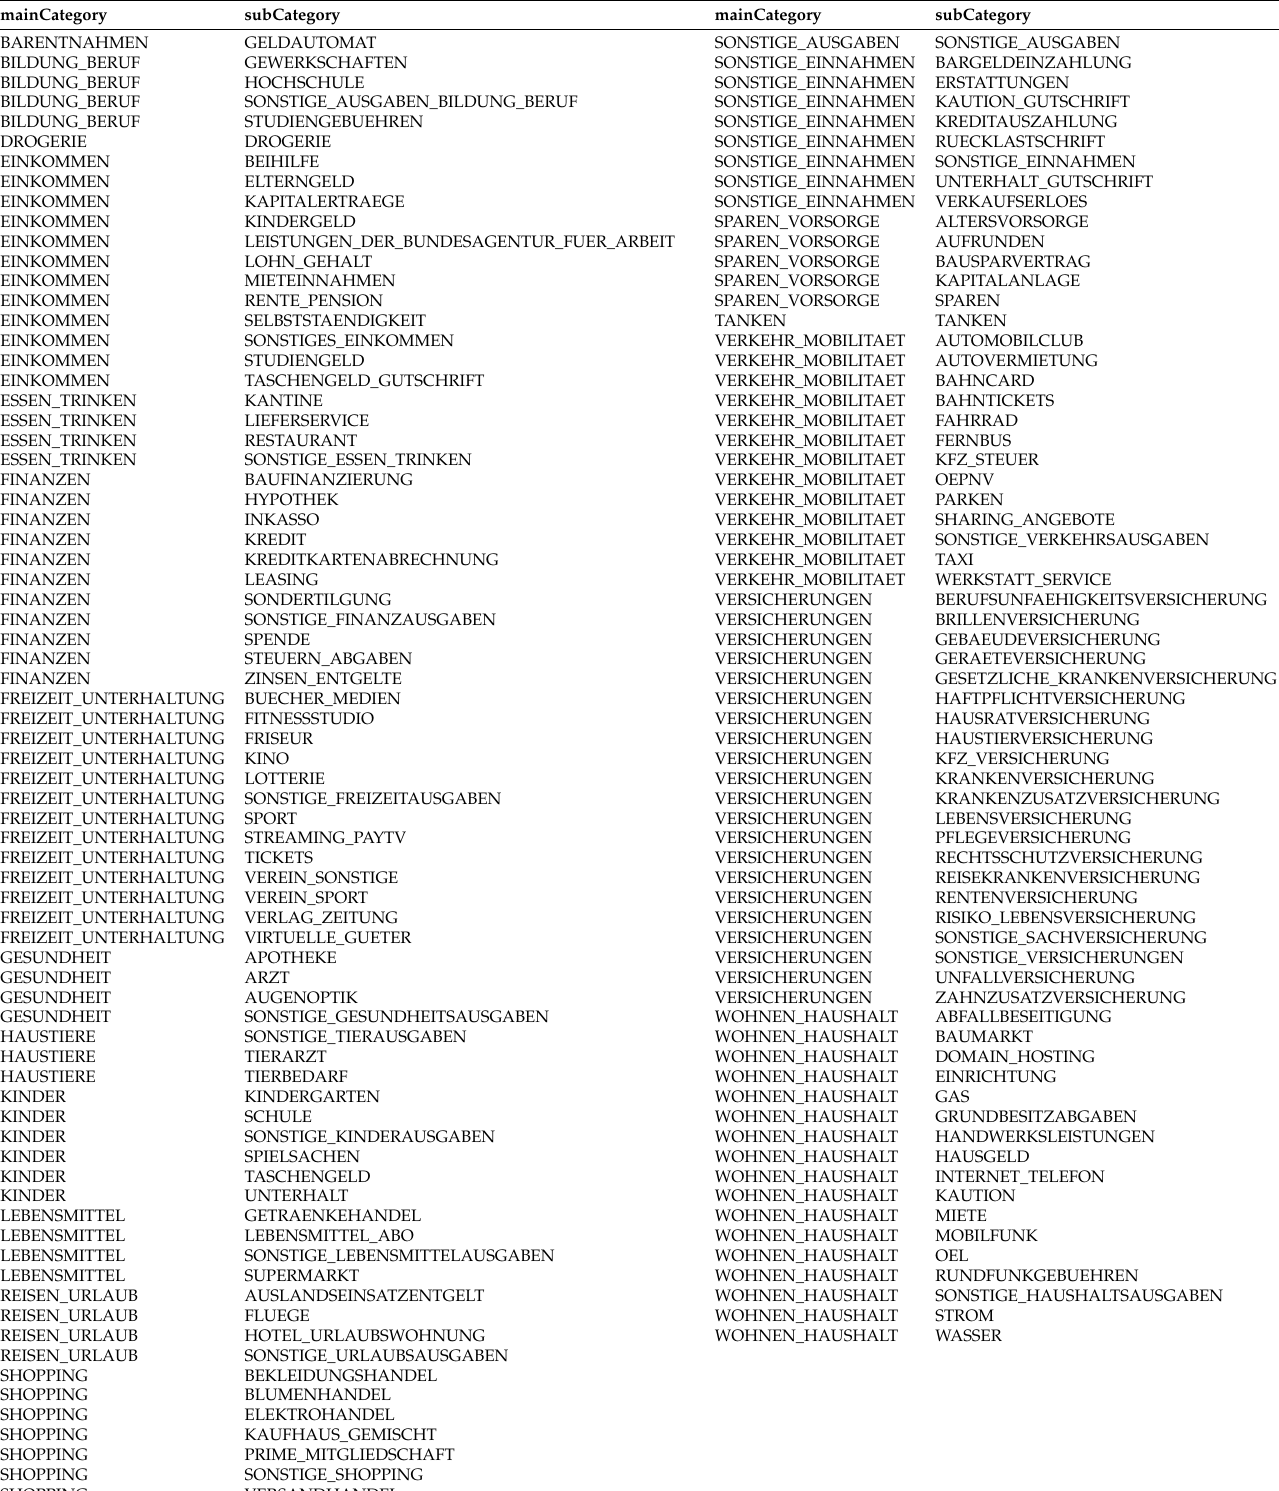
Table A12. Transaction labels. Source: Own